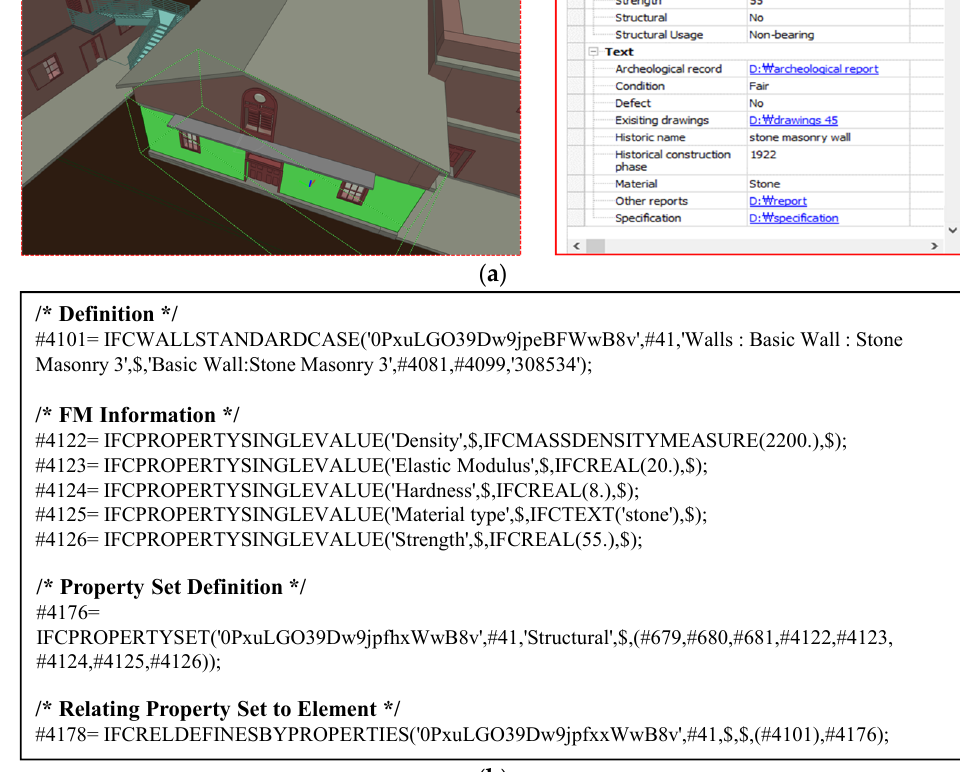
Figure 13. NED IFC model: ( a ) NED IFC model in IFC viewer showing the geometrical and semantic information; and ( b ) IFC SPF file presenting the heritage element definition and property set.